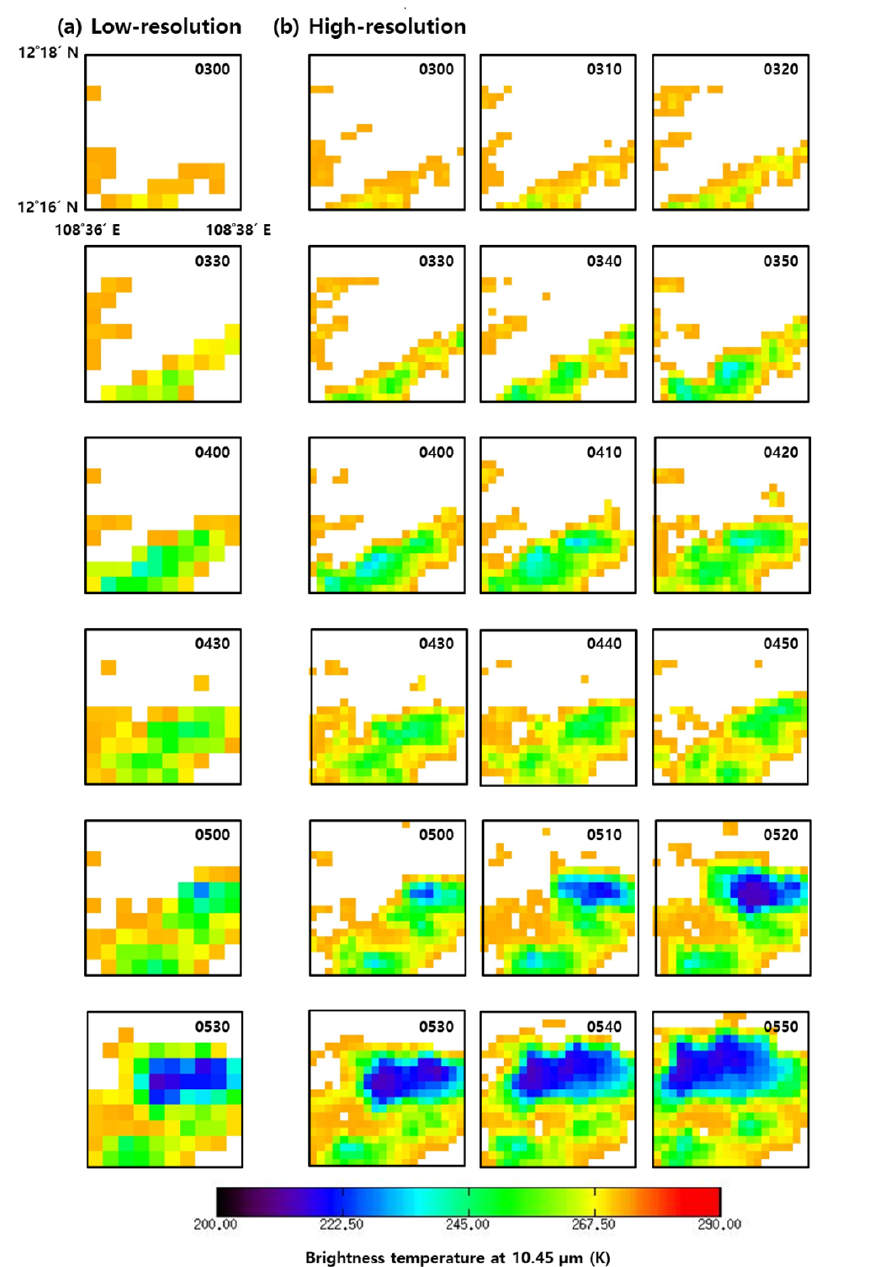
Figure 4. An example of the thunderstorm development process through BT11 images (10 August 2017 at 03:00–05:50UTC) with (a) the low-resolution (4km and 30min) imagery and (b) the high-resolution (2km and 10min)